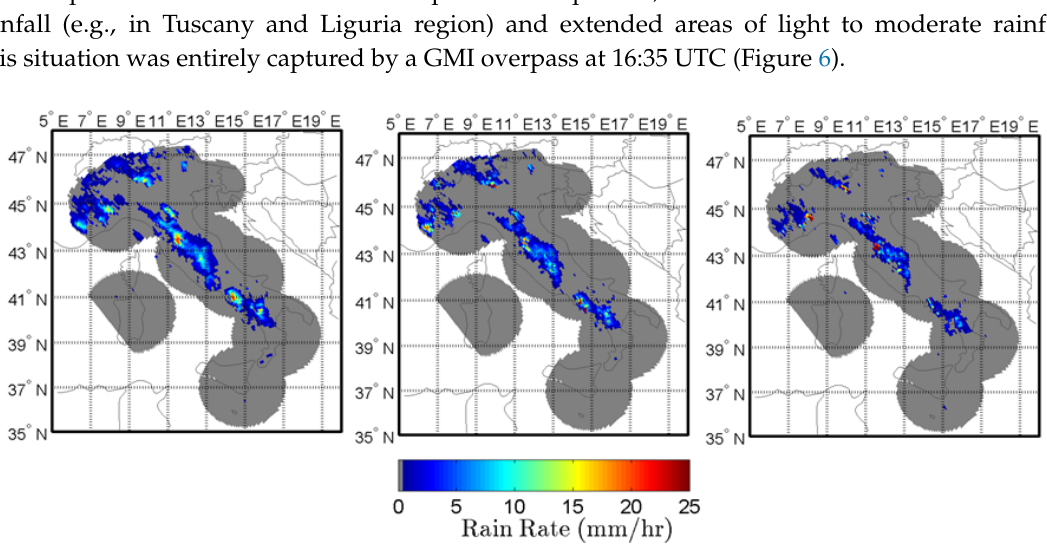
Figure 6. Precipitation event over Italy on 9 August 2015, at 16:35 UTC. Precipitation estimates from PNPR v3 ( left panel ), GPROF V05 ( middle panel ) and ground radar observations, at 16:40 UTC ( right panel ) are shown. The GMI products are shown only on the area covered by the radar network.